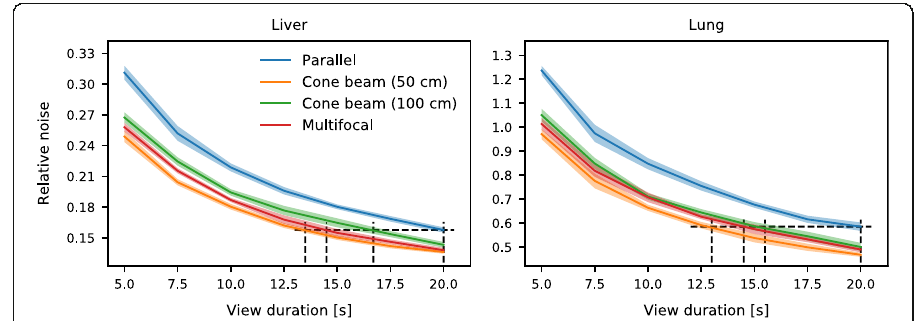
Fig. 12 Noise levels, normalized to the mean activity, for the four collimators obtained by reconstruction with Monte Carlo-based scatter correction. The dotted framework shows the time needed for the cone